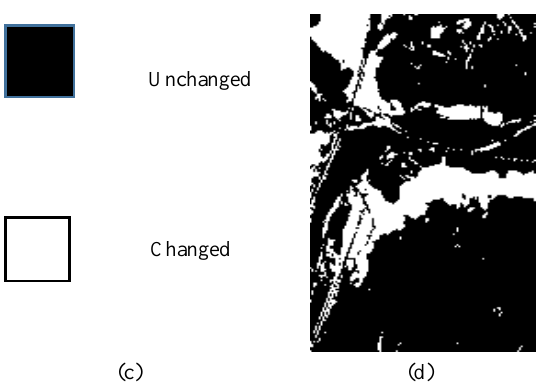
Figure 3. The (a) and (b) presented false-colour composite of the original hyperspectral images acquired in 2006 and 2006 of Shadegan wetland in Iran respectively. The (c) and (d) showed Ground truth with the legend.